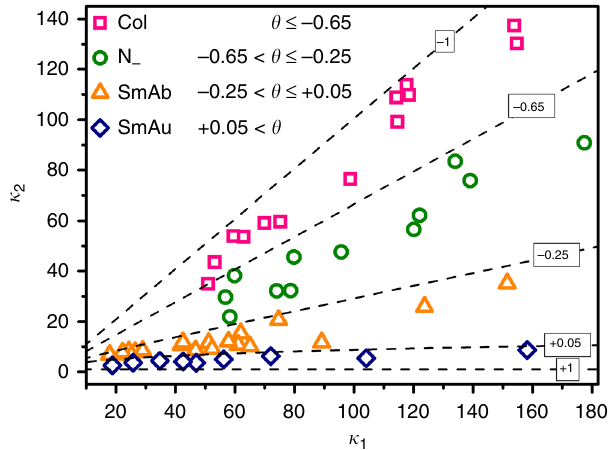
Fig. 5 Colloidal shape biaxiality effect on the phase diagram. Phase diagram of cuboidal particles as a function of κ 1 and κ 2 . The dashed lines correspond to different θ values as shown on the